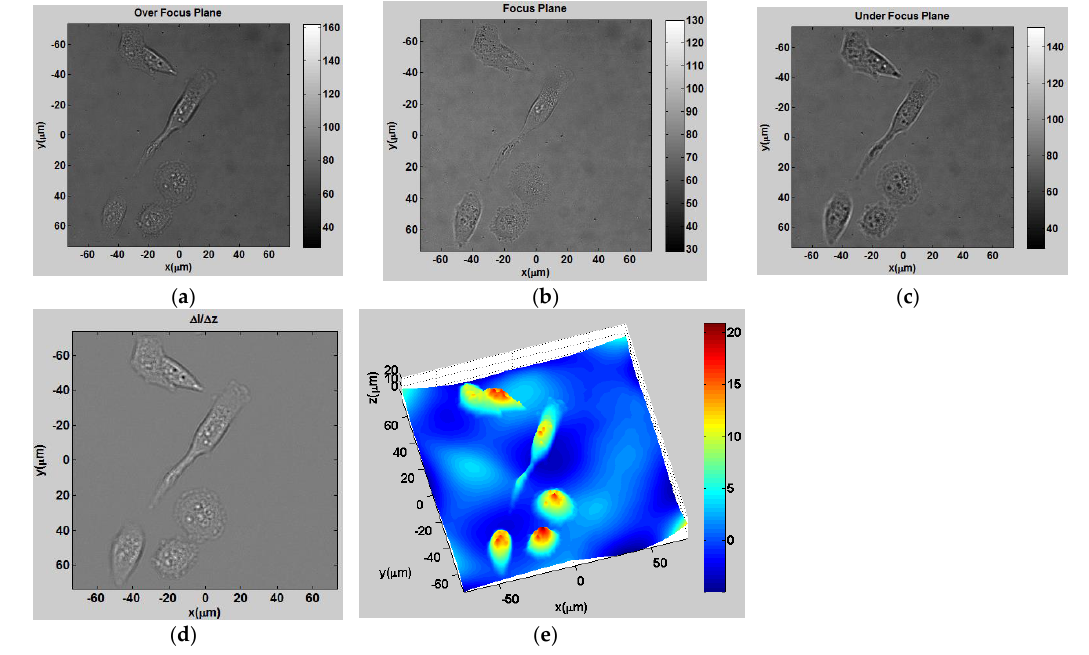
Figure 10. ( a – c ) Intensity distributions of cancer cells at 𝛥 z = 1, 0, −1 mm, respectively; ( d ) derivative of intensity over the propagation direction; and ( e ) height distribution after TIE reconstruction. J. Imaging 2016 , 2 , 30 12 of 15